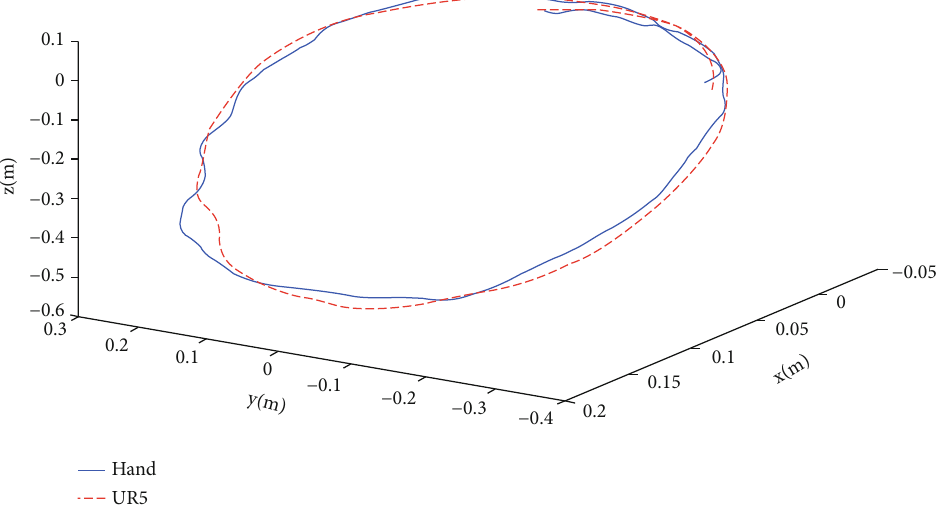
Figure 8: Motion trajectories of hand and the end e ff ector of